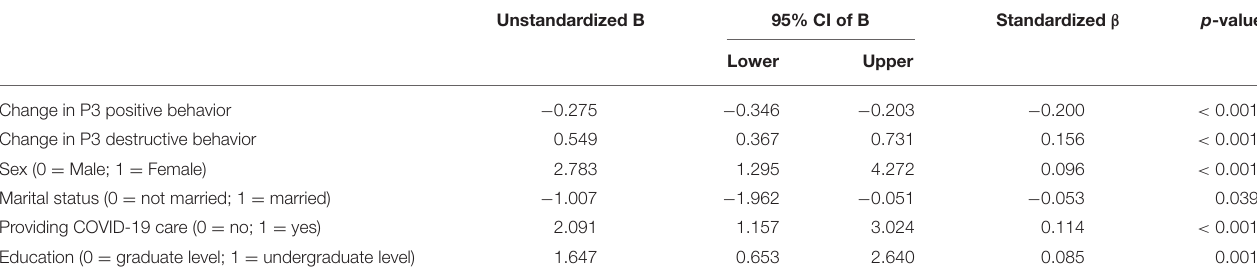
TABLE 4 | Multiple linear regression analysis investigating the influence of P3 behavior scores on distress.